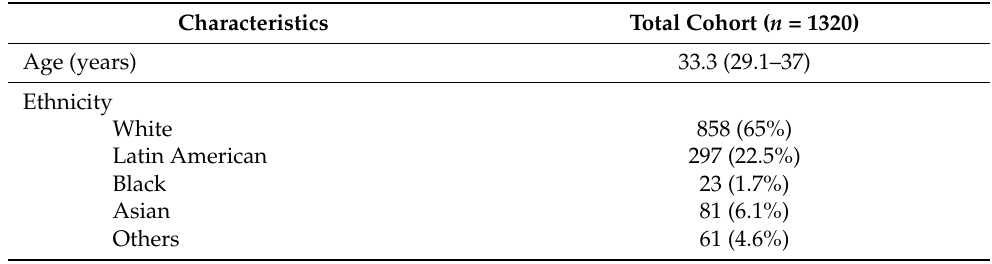
Table 1. Pandemic cohort baseline